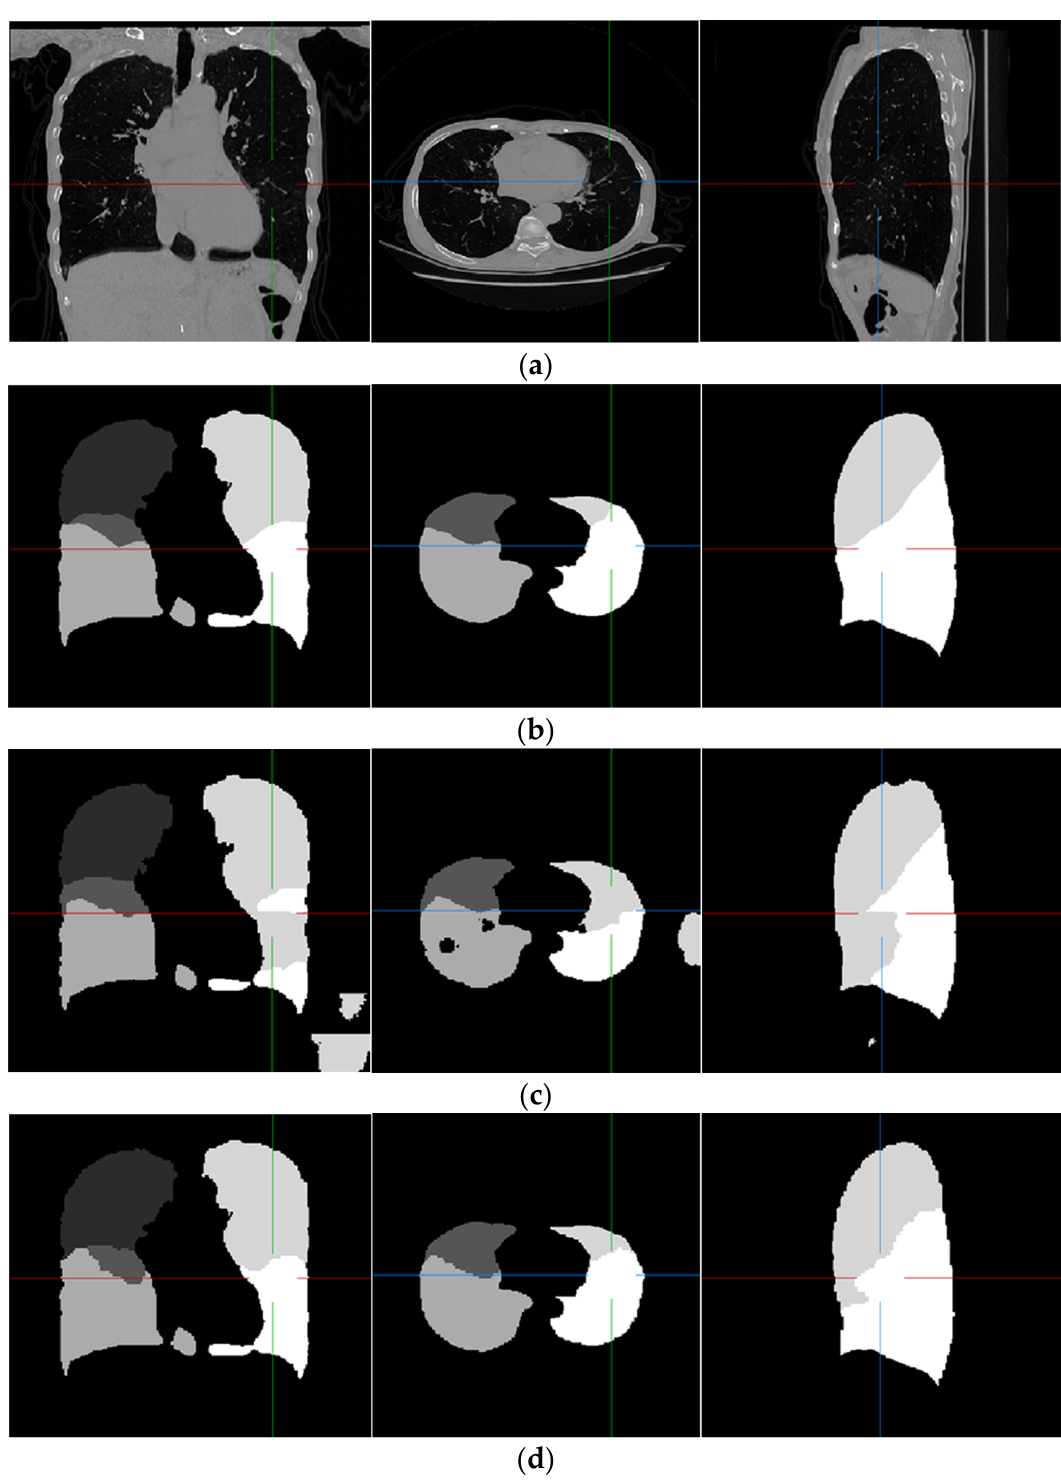
Figure 4. An example of the results of the experiment. ( a ) Original scan; ( b ) ground-truth; ( c ) FRV- Net; and ( d ) proposed method.